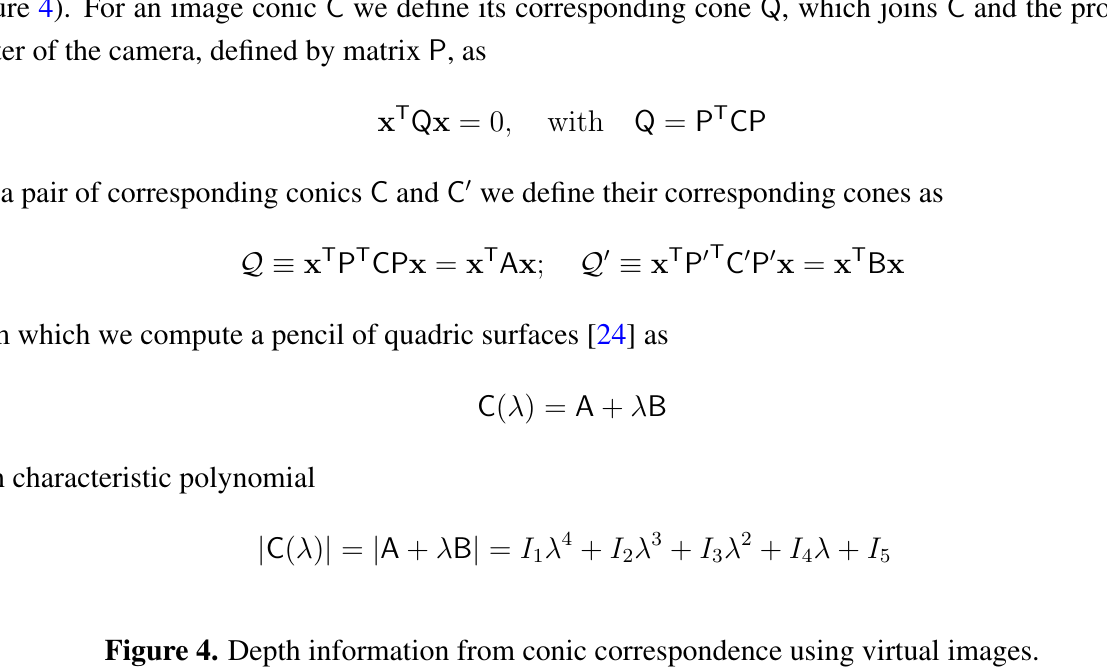
Figure 4. Depth information from conic correspondence using virtual